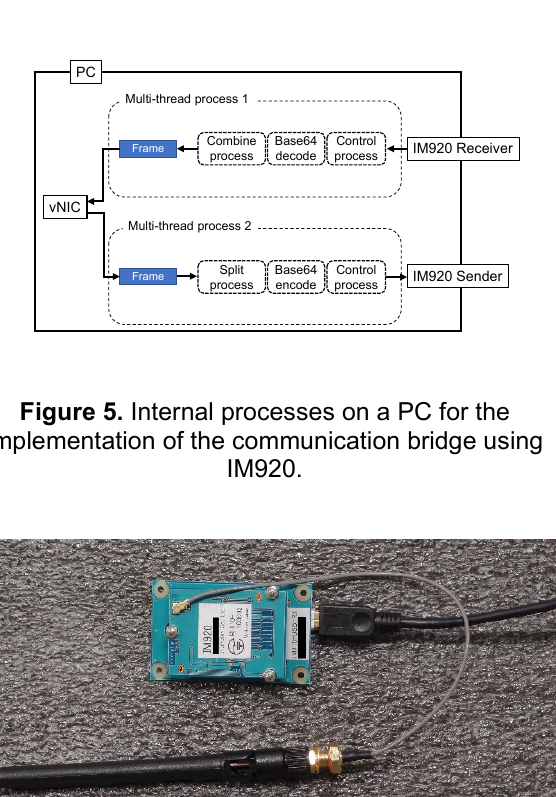
Table 1. Specifications of PCs for implementation.